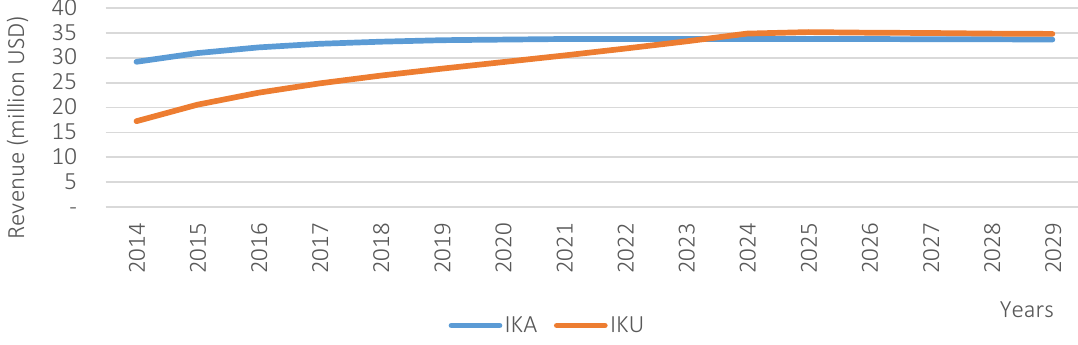
Figure 3. Simulation graph of IKU scenario